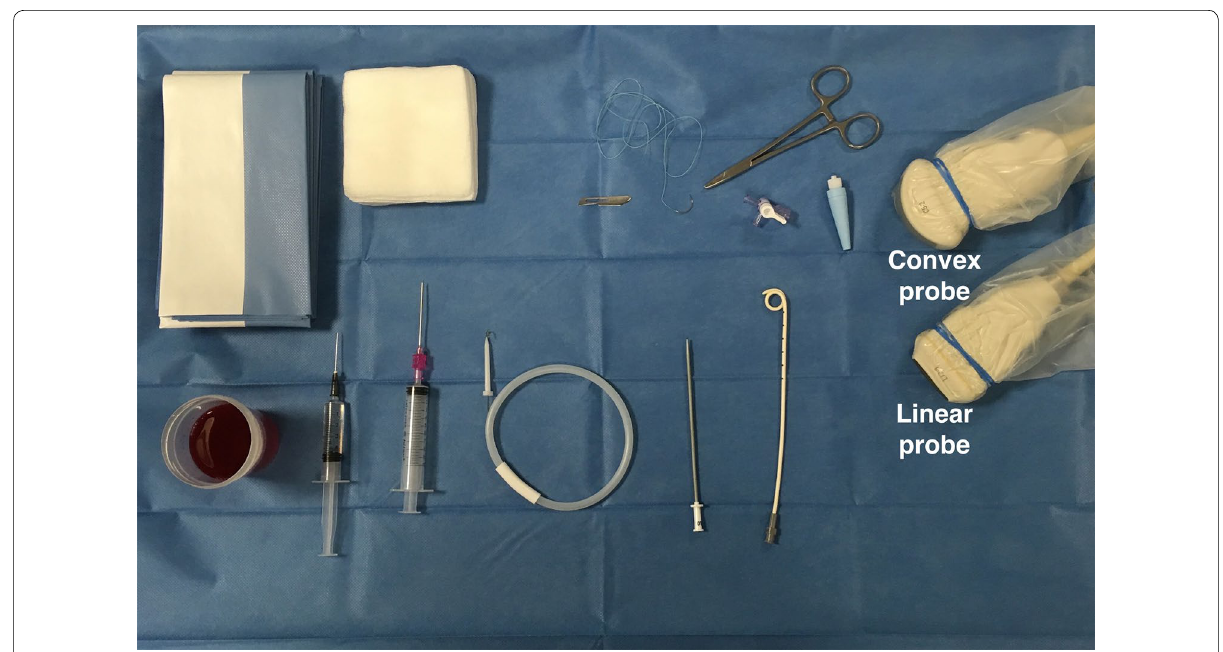
Fig. 1 A set of pleural drainage tools on the